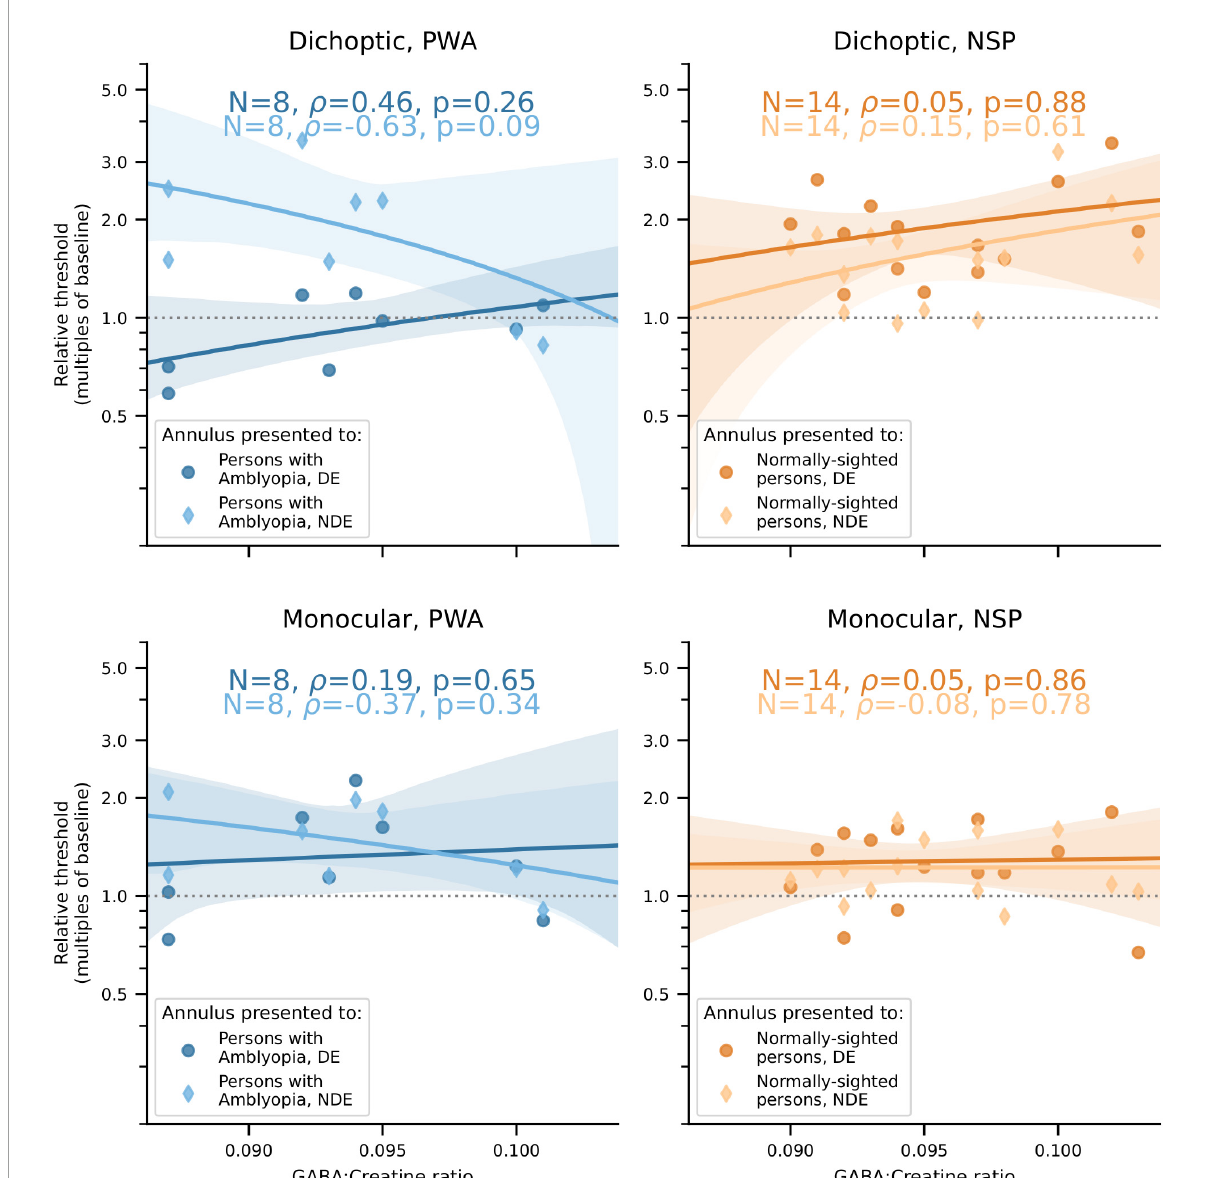
FIGURE5 Relationships between iso-oriented surround suppression ( Figure 2B ) and visual cortical GABA levels. Top row: Dichoptic presentation. Bottom row: Monocular presentation. Left column: PWA. Right column: NSP. Shading indicates 95% bootstrapped confidence intervals of the best linear fit. The difference in the strength of the GABA/surround suppression correlation between the two eyes of PWA was significant for dichoptic presentation ( p = 0.036).